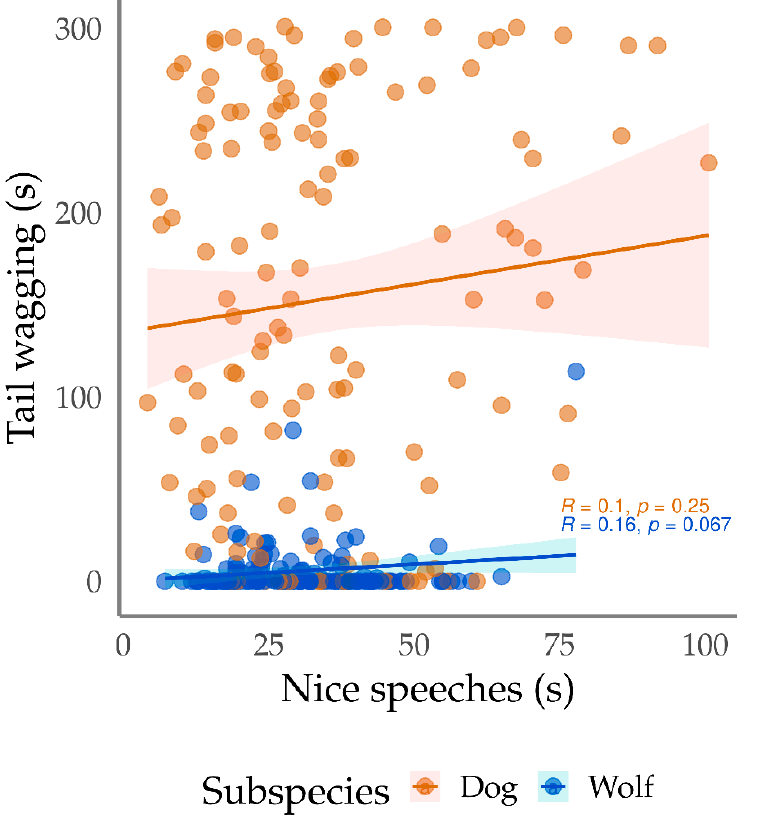
Figure 2 . Dispersion of the time that dogs ( Canis familiaris ) and wolves ( Canis lupus ) spent tail wagging in Positive Reinforcement Training sessions, as a function of the duration of “nice speeches” during the sessions. Y axis = tail wagging duration of dogs and wolves (s); X axis = duration of nice speeches (s). Each dot represents an individual training session.